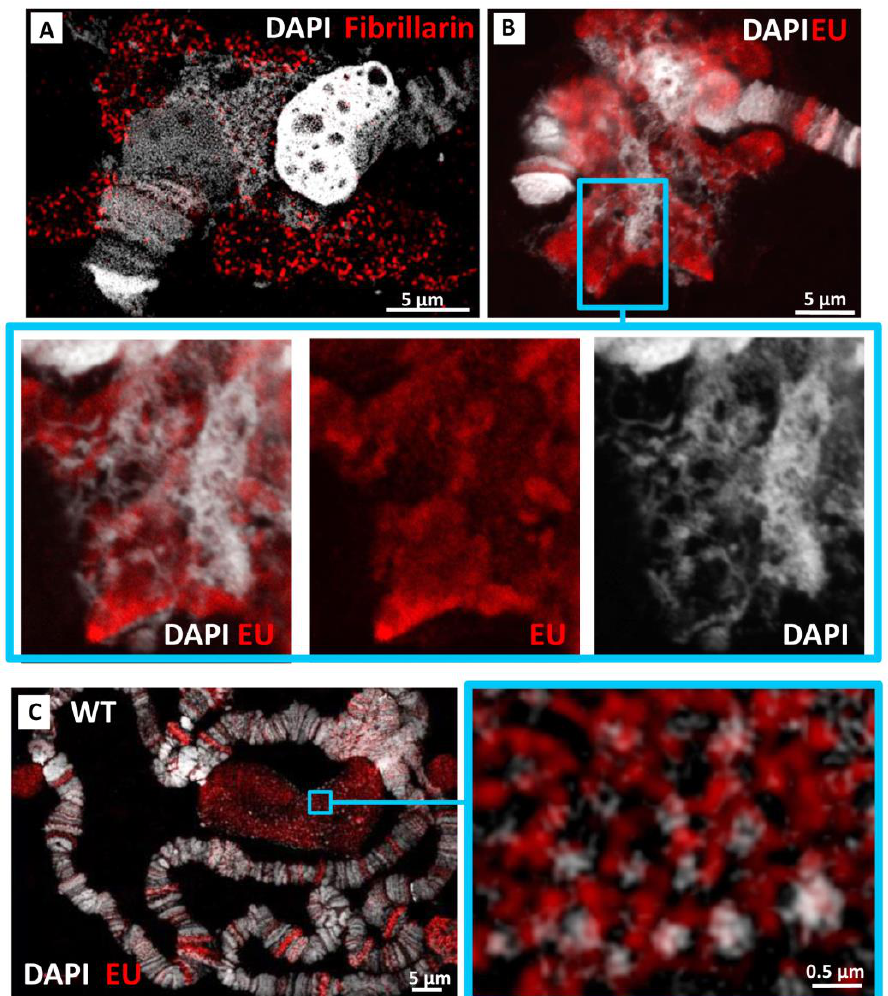
Figure 6. Fibrillarin and nascent transcripts are localized predominantly in the extrachromosomal part of nucleoli in In(1)sc 8 + 19EHet; Rif1 1 polytene chromosome preparations. ( A ) Fibrillarin im- munostaining in In(1)sc 8 + 19EHet; Rif1 1 chromosome. ( B ) In(1)sc 8 + 19EHet; Rif1 1 chromosome after a 15-min EU pulse. ( C ) EU incorporation assay in the nucleolus of wild-type chromosome preparations. A and C images represent single 3D-SIM slices. B image represents a confocal slice.